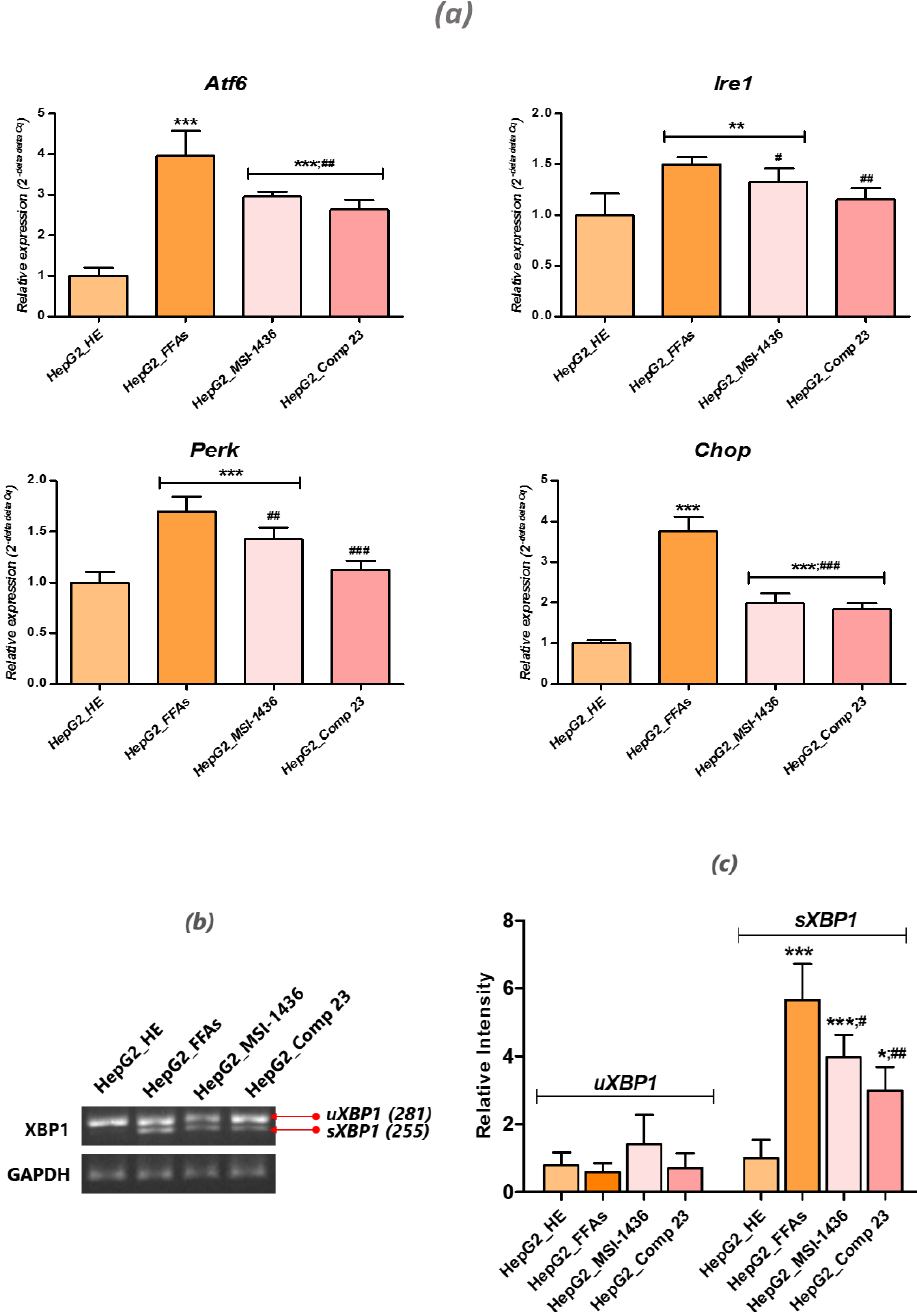
Figure 6. Effects of MSI-1436 and compound 23 on palmitate/oleate-induced ER-stress in HepG2 cells. ( a ) Bar charts summarize the mean relative expression ± SD of ER-stress related transcripts. ( b ) T-PCR product visualization of the uXBP1 and sXBP1 transcripts. ( c ) Histograms showing the relative intensity of x-box binding protein (uXBP1) and sXBP1 mRNA. Representative data from three independent experiments are shown as mean ± SD ( n = 3). An asterisk (*) indicates a comparison of all treated groups to untreated healthy cells. A hashtag (#) indicates a comparison of PTP inhibitor treated groups to FFA-challenged cells. * / # p < 0.05, ** / ## p < 0.01, *** / ### p < 0.001. HepG2_HE: HepG2 healthy untreated cells; HepG2_FFAs: HepG2 cells exposed to the palmitate / oleate combination; HepG2_MSI-1436: HepG2 cells pre-treated with 1 µ M MSI-1436 inhibitor and exposed to the palmitate / oleate combination; HepG2_Comp 23: HepG2 cells pre-treated with 1 µ M compound 23 inhibitor and exposed to the palmitate / oleate